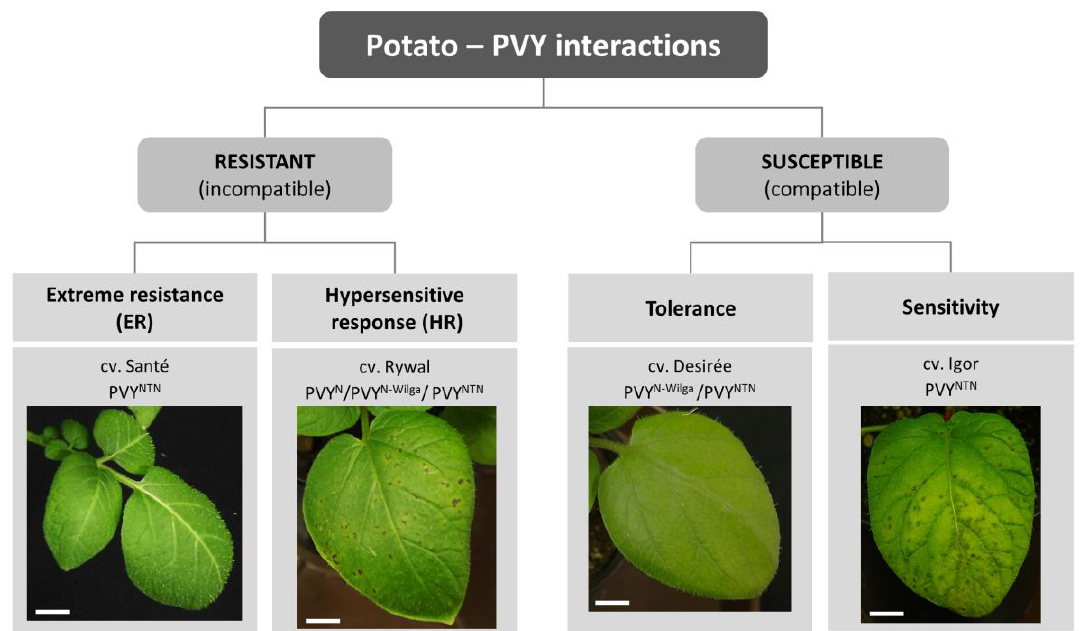
Figure 1. Outcomes of potato-potato virus Y (PVY) interaction. Outcomes depend on the host genotype, viral strain, and environmental conditions, and are manifested as di ff erent responses in terms of virus multiplication and disease symptoms’ development. Photos present symptoms appearing on the inoculated leaves 6 days after inoculation in selected potato cultivars in optimal environmental conditions. Examples of viral strains that give the same outcome are shown for each cultivar. Scale = 1 cm.